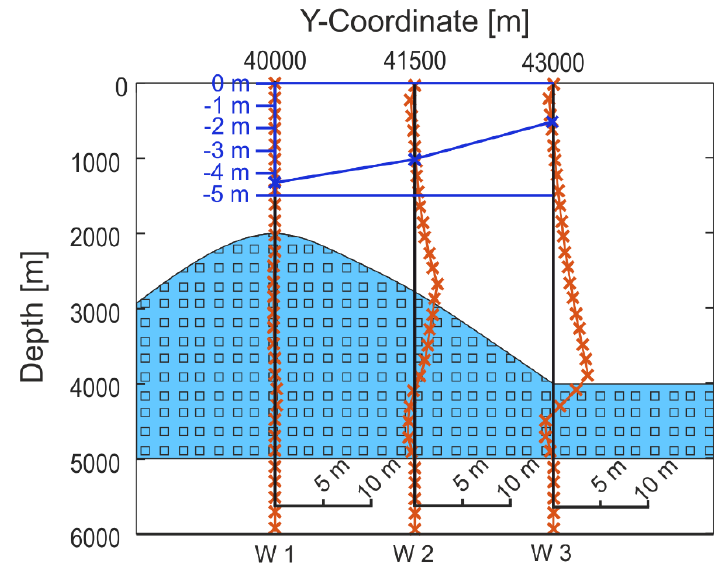
Figure 13. Vertical and lateral movements along the hypothetical wells W1–W3 (See Figure 2c). The red line crosses show the movement in y-direction. The blue line and crosses show the relative surface movement related to the average subsidence of the whole model for Model B-04a.